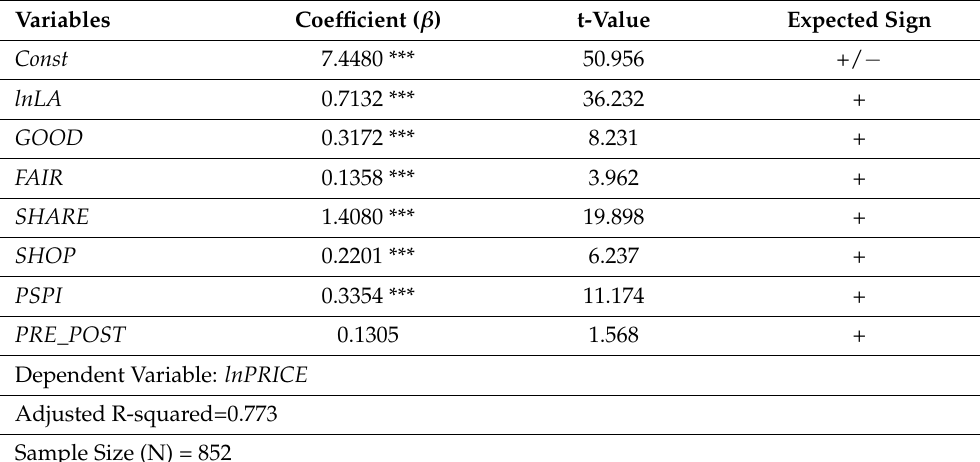
Table 5. OLS Regression Results of Model